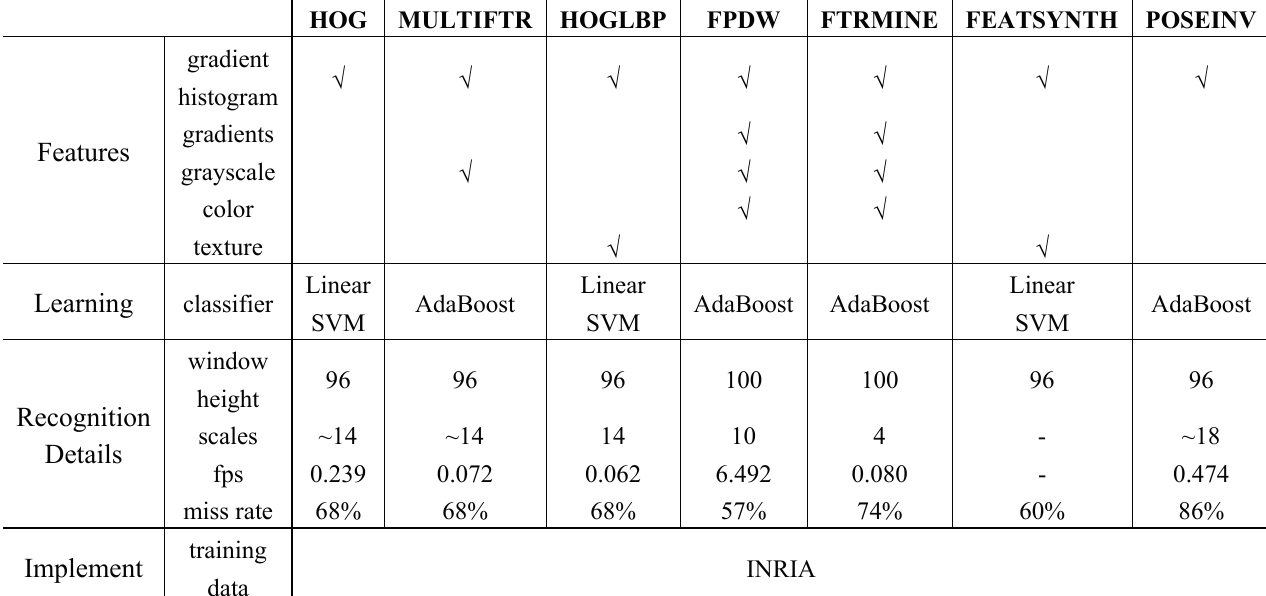
Table 11. Comparison of pedestrian recognition